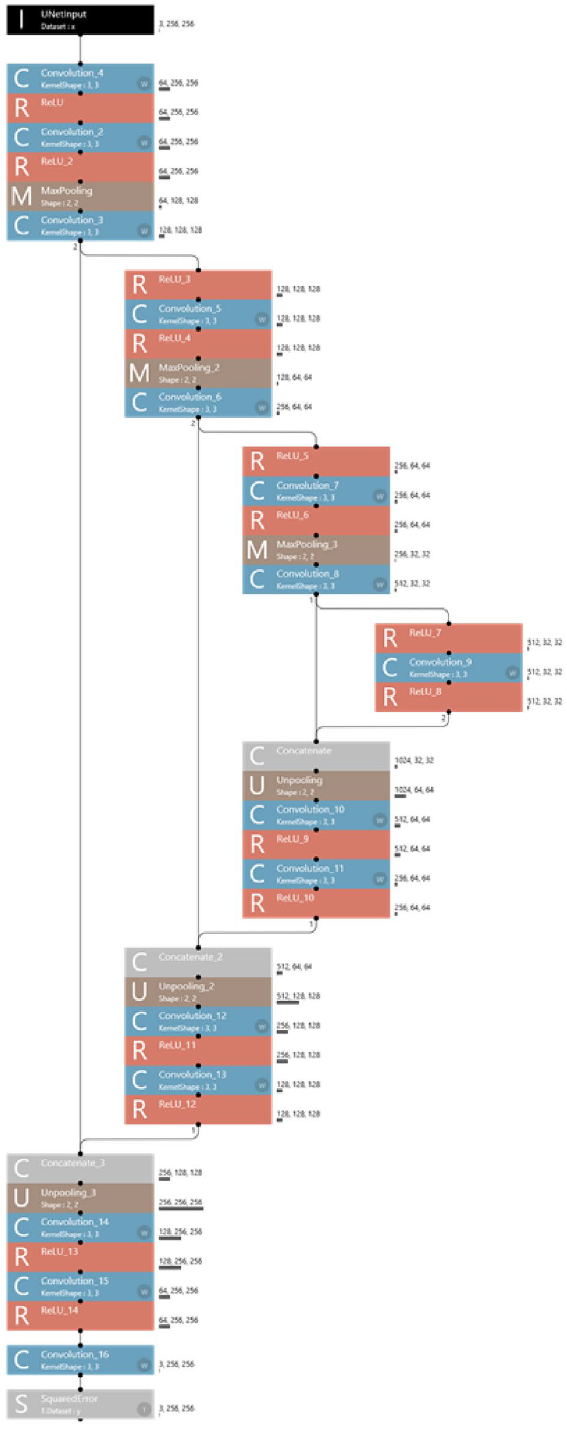
Figure 3. The U-Net neural network used for this